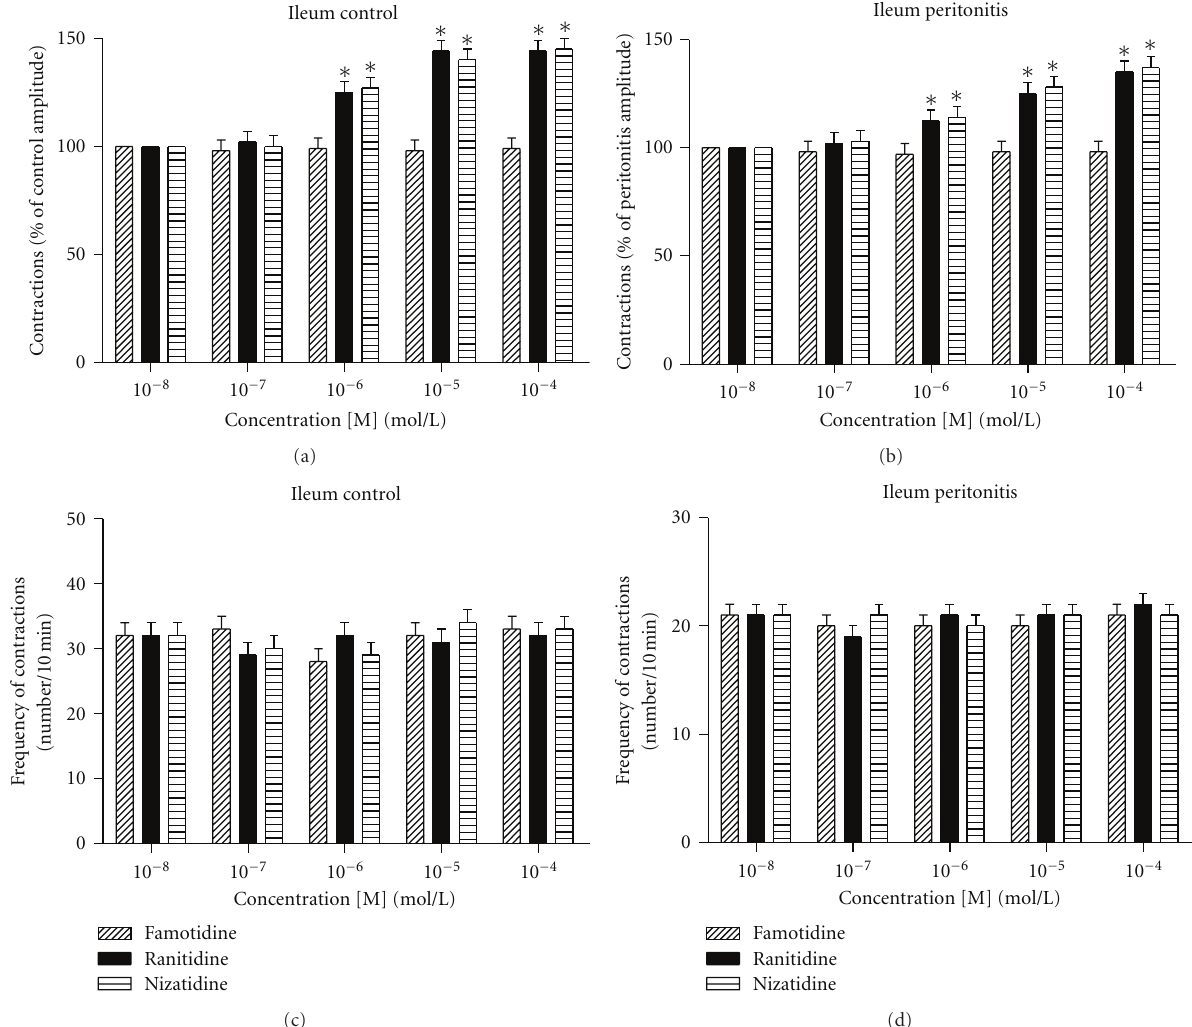
Figure 3: Amplitudes of the contractions induced by famotidine, ranitidine, and nizatidine. (a) Control group; (b) peritonitis group; both were calculated as the percentage of the initial contractions. ( ∗ P < 0 . 05 versus initial contractions; analysis of variance followed by Tukey test.) Changes induced by famotidine, ranitidine, and nizatidine in the frequency of spontaneous contractions. (c) Control group; (d) peritonitis group. Both were expressed as the number of contractions for